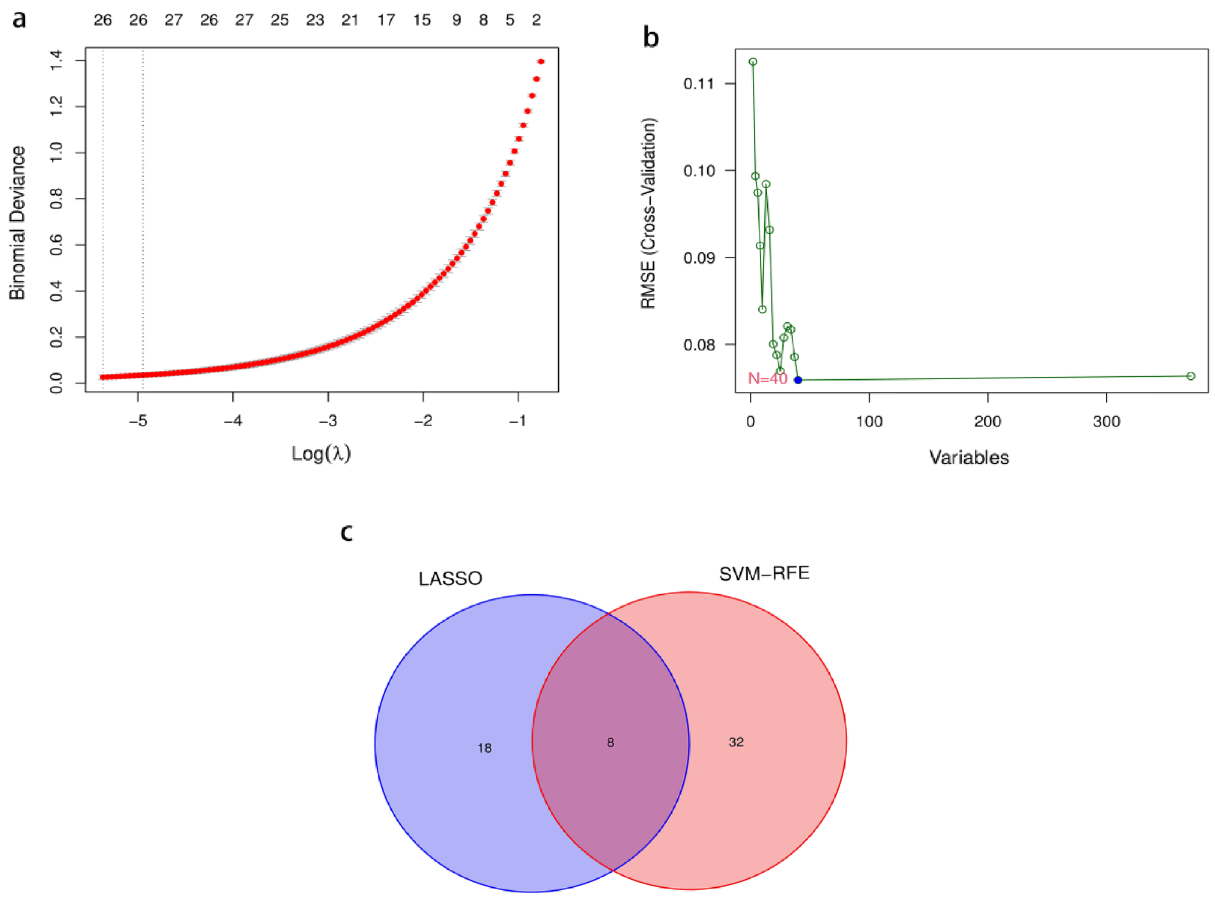
Figure 4. Machine learning approach to screen for NSCLC-related biomarkers. The point corresponding to the smallest vertical coordinate is the characteristic genes. ( a ) Results of screening biomarkers based on LASSO algorithm. ( b ) Screening results for biomarkers based on the SVM-RFE algorithm. ( c ) The Venn diagram shows the results of the intersection of the LASSO algorithm and the SVM-RFE algorithm, with the intersection resulting in eight